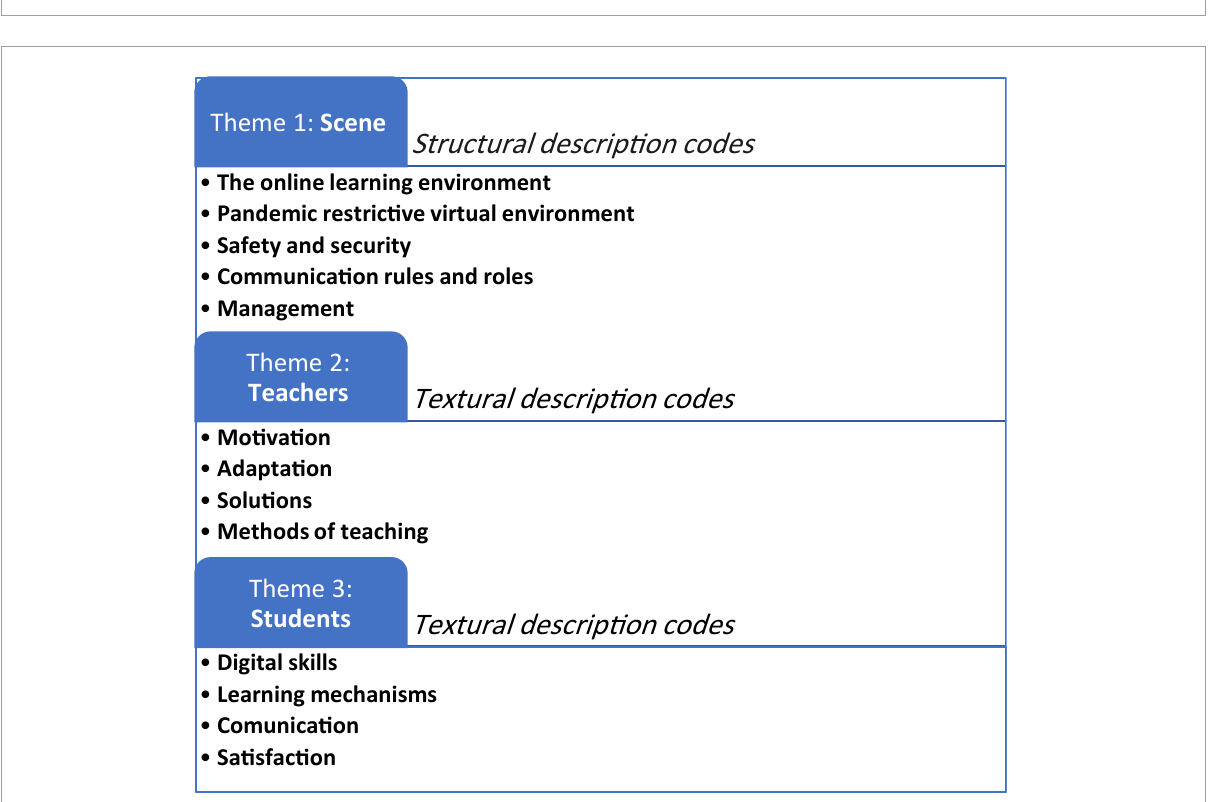
FIGURE3 The main themes and associated codes.